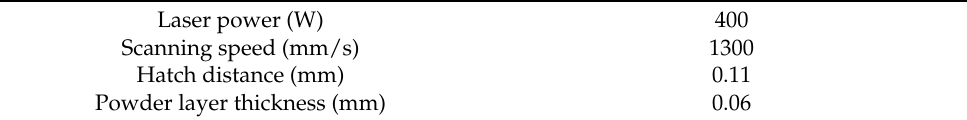
Table 3. The processing parameters of SLM.